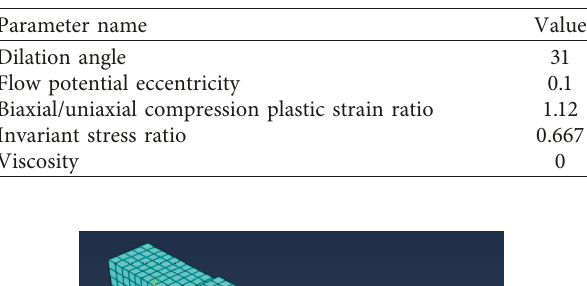
Figure 2: Profile and cross section details of the strengthened beam [3]. Table 1: Parameters of the CDP model under compound stress [15].